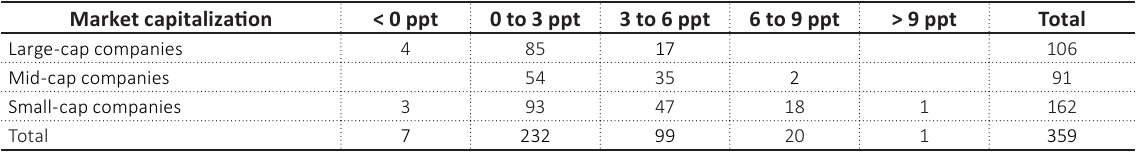
Table 2. Excess returns (VA XIRR – SIP XIRR) according to market capitalization: Frequency